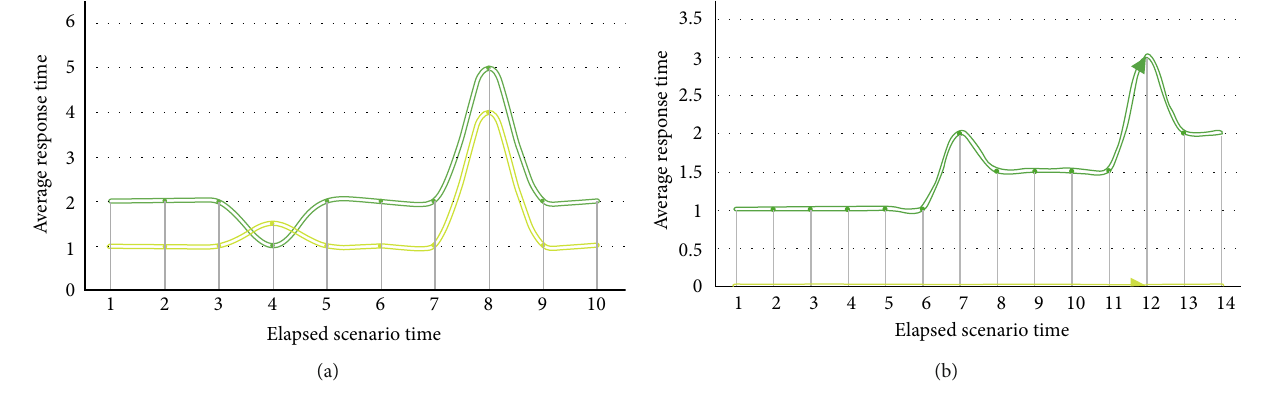
Figure 1: Average transaction response time.